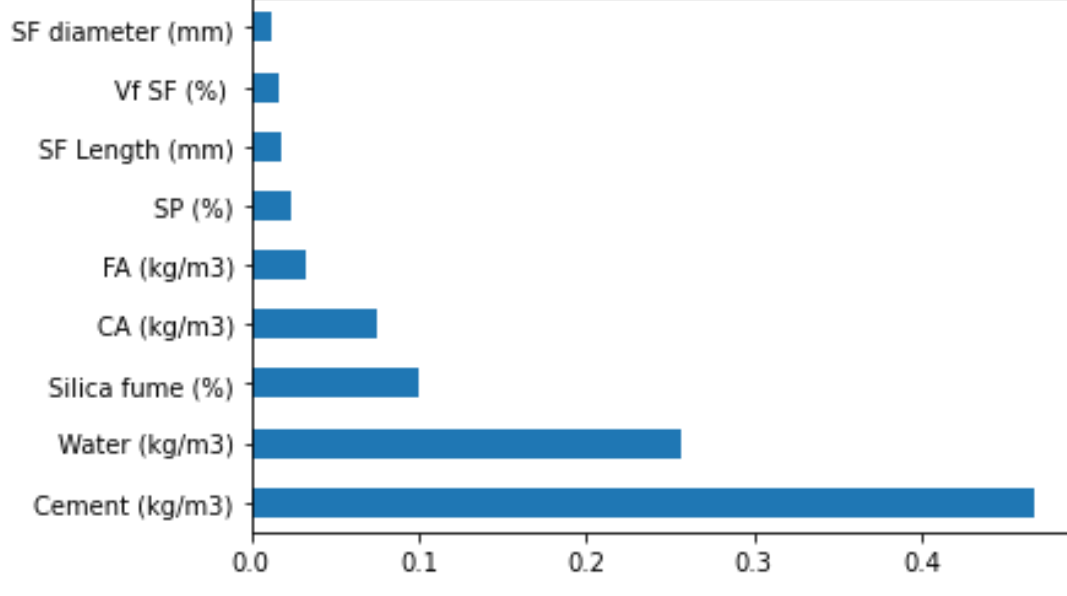
Figure 20. Compressive strength feature importance.